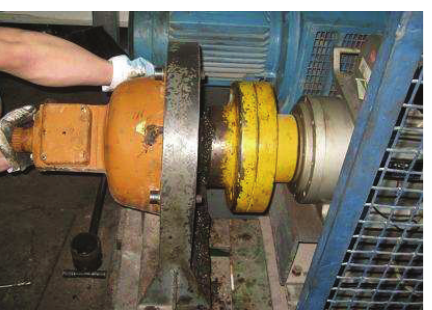
Figure 4: The antifalling safety devices to be detected.